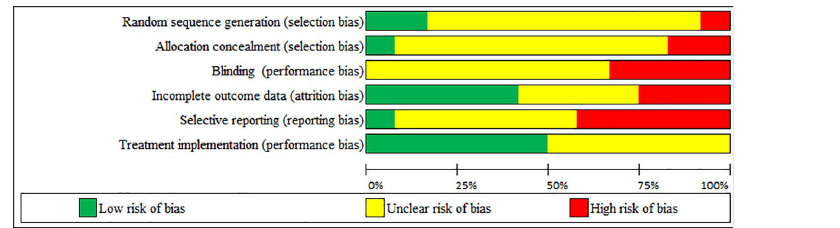
Fig 4. Proportion of studies for each of the six potential sources of